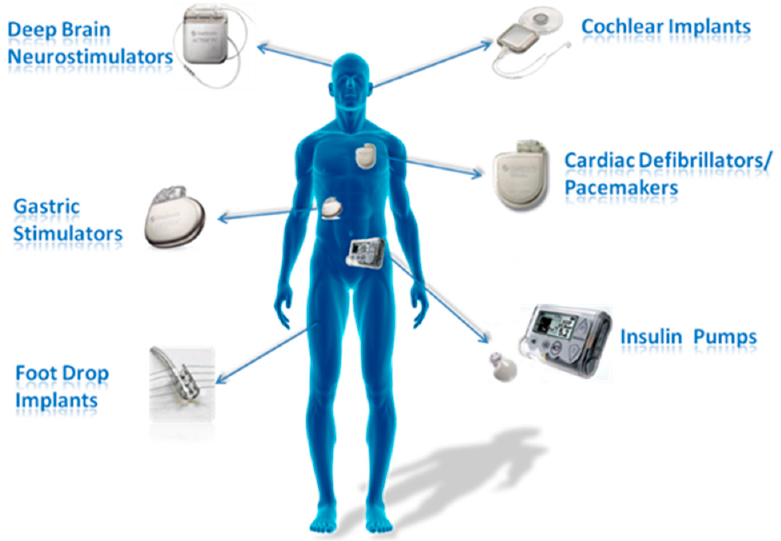
Figure 13. Common implantable devices.